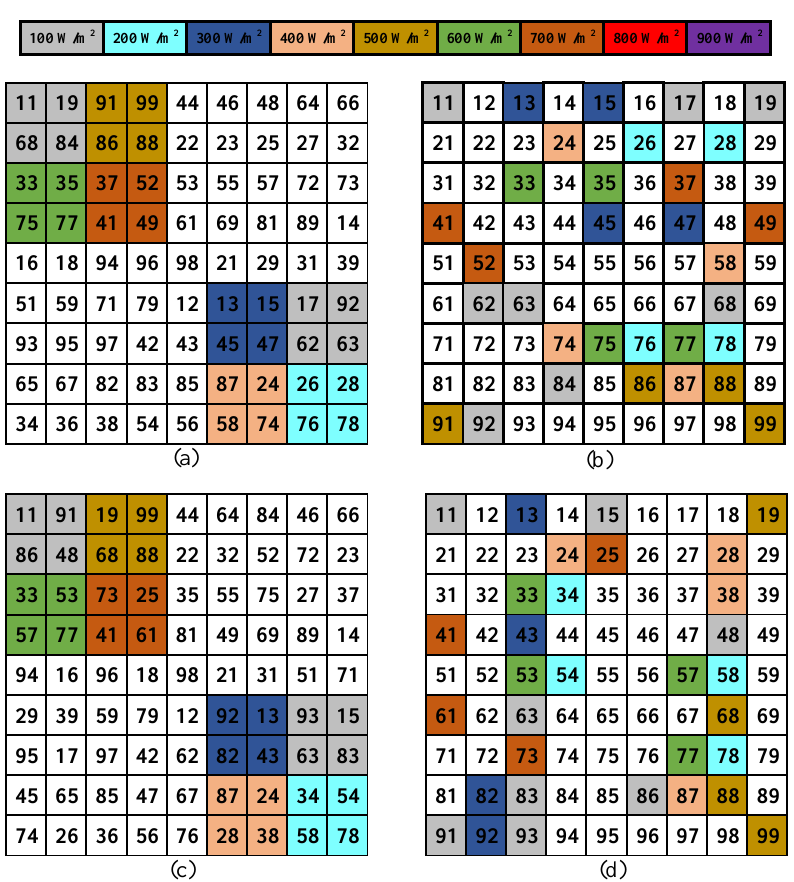
Figure 10. ( a ) OEP; ( b ) shade dispersion of OEP; ( c ) IOEP; ( d ) shade dispersion of IOEP for 9 × 9 PV array at Top-Left and Bottom-Right PSC. The PV characteristics for case-V (Top-Right and Bottom-Right) are shown in Figure 11.